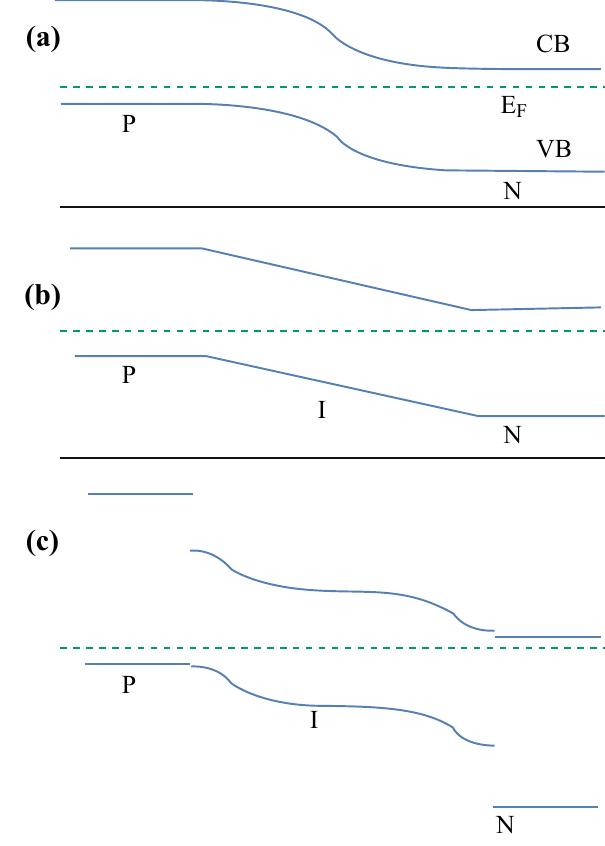
Fig. 1 a Single PN junction model for PSCs and b new double PN junction model improved for planar perovskite solar cells with J L (the light induced current), J D (the dark current or the forward current of PN junction diode under the sunlight), R s (the series resistance), R sh (shunt resistance, a fictional parameter to represent the size of leakage current), J (output current of the cell) and V (voltage flowing through the external load). c Planar heterojunction perovskite solar cells with